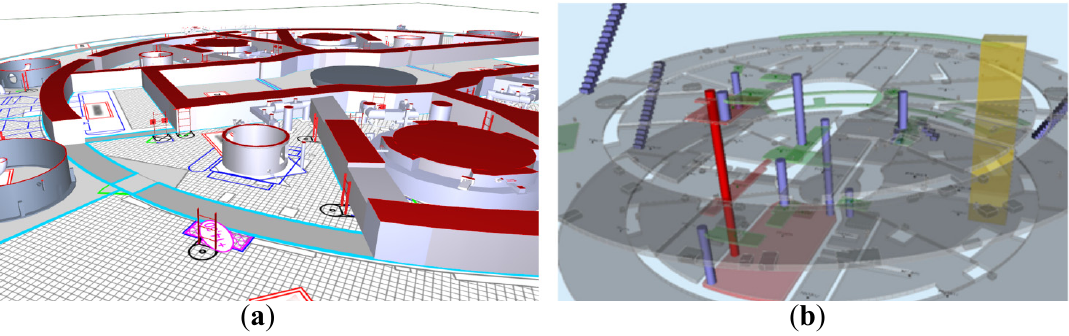
Figure 9. 2D as-built floor maps ( a ) updated using the 3D as-built dataset, laser scans and panoramic images; ( b ) An interactive Virtual Reality Modeling Language (VRML) visualization of a semantic, geometric and topological representation of the building, based on the as-built floor maps [1].